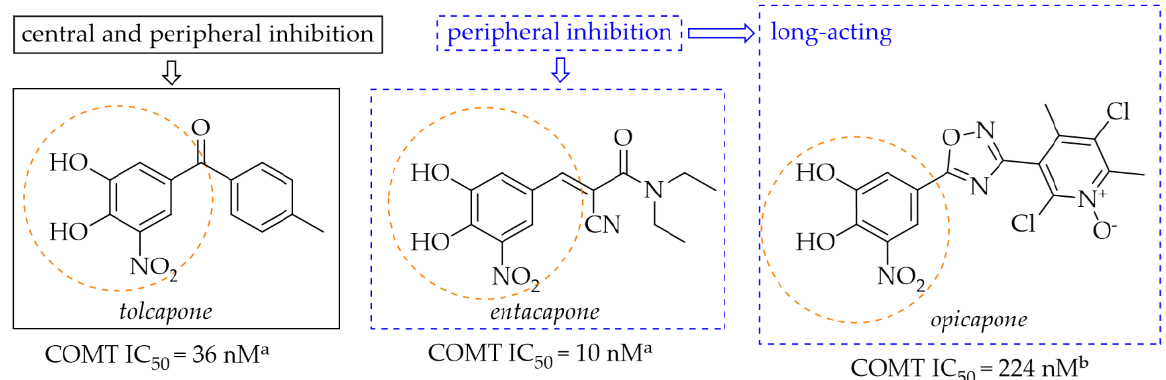
Figure 12. Chemical structures of second ( tolcapone and entacapone )- and third ( opicapone )-generation COMT inhibitors; a IC 50 values in rat liver homogenates, data from ref. [36], b IC 50 values in rat liver homogenates, data from ref. [38].